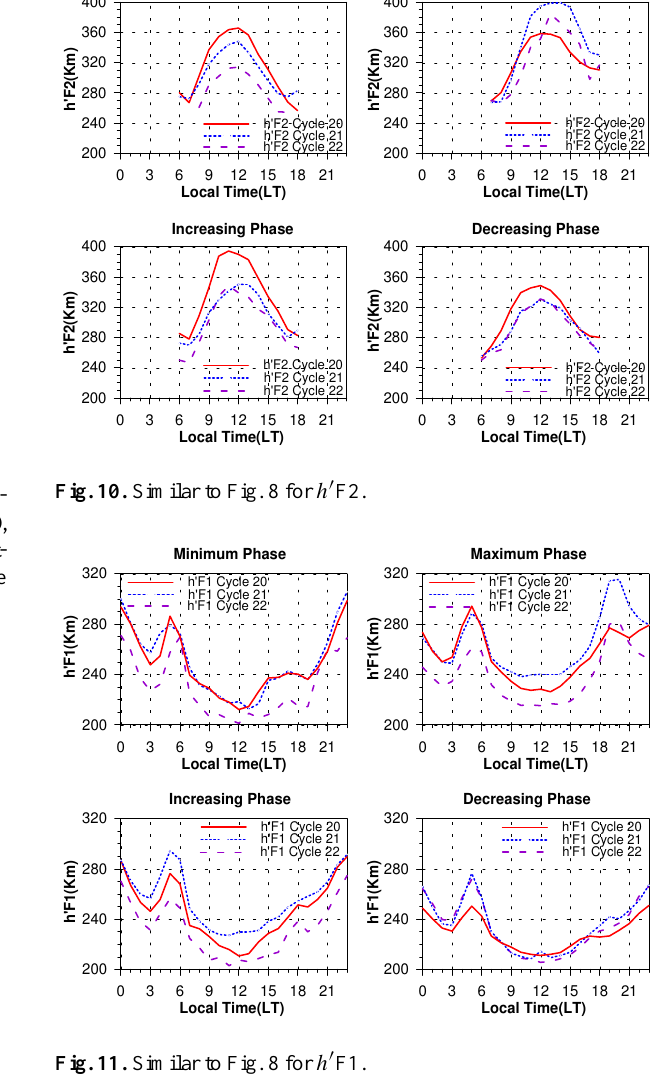
Fig. 11. Similar to Fig. 8 for h 0